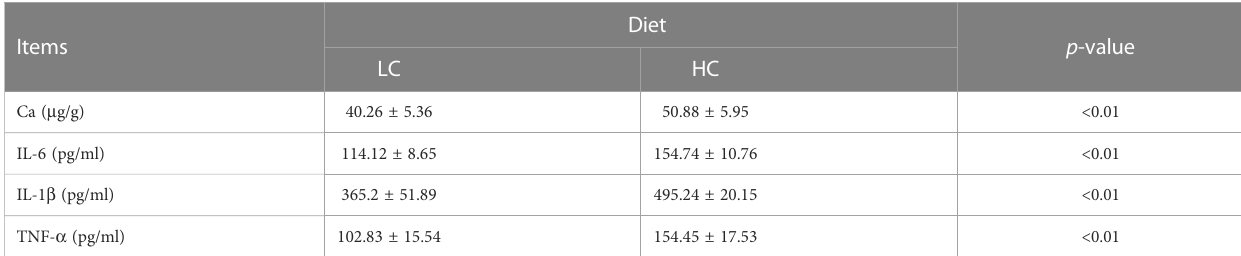
TABLE 4 Effects of different diets on the concentration of Ca 2+ in mammary tissue and proin fl ammatory cytokine content in the plasma of dairy cows.